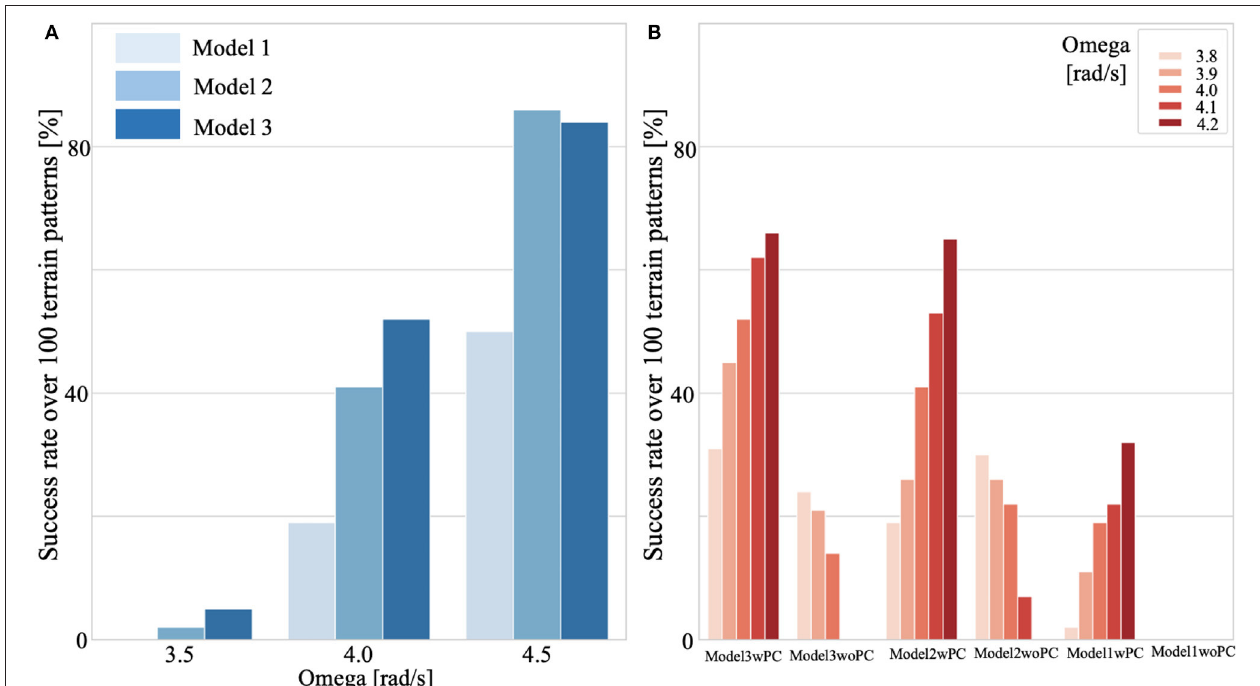
FIGURE 9 | Adaptability on uneven terrain. We simulated test environments that consisted of 10 m of flat ground, followed by 20 m of uneven terrain, and another 10 m of flat ground ( Supplementary Movie 1 ). We verified the walking performance for 100 randomly generated uneven-terrain patterns for each model (1,2,3) [with/without posture control (PC)], and for each control parameter. We judged the success case as the condition in which the bipedal model successfully walked 40 m ground. (A) Comparison of success rates for continuous walking on 100 uneven terrain patterns. All models included PC. (B) Effects of PC on adaptability. Model 3 with PC shows high environmental adaptability to a wide range of ω . Note that the same terrain patterns were applied in all cases.